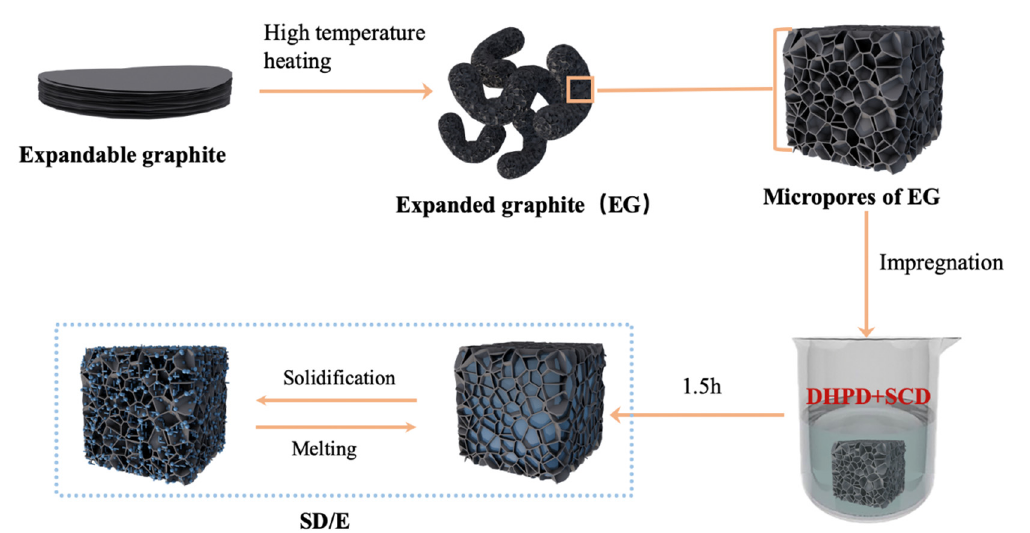
Figure 1. The preparation process of SD/E .